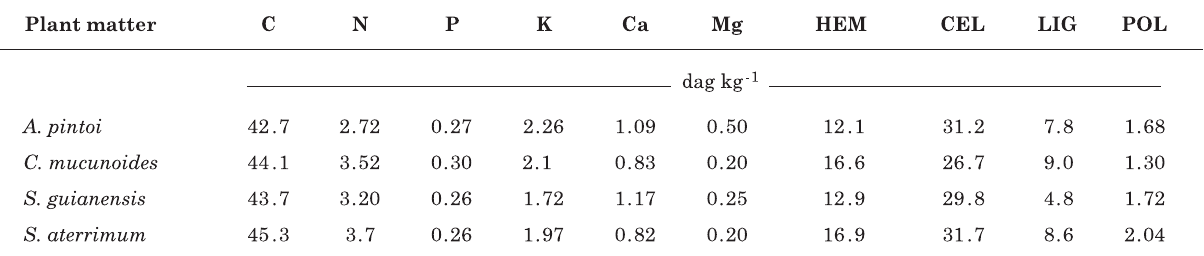
HEM: hemicellulose; CEL: cellulose; LIG: lignin; POL: total soluble